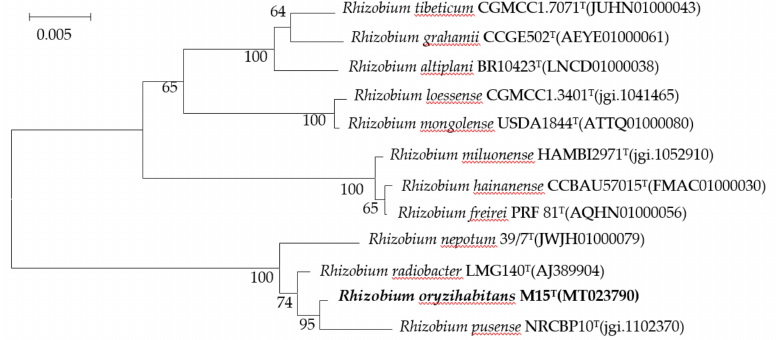
Figure 1. Phylogenetic tree generated with the neighbor-joining algorithm based on 16S rRNA gene sequences showing the phylogenetic positions of strain M15 T and related taxa. Bootstrap values with more than 50% are shown on the nodes as percentages of 1000 replicates. Rhizobium grahamii CCGE502 T (AEYE01000061) was used as an outgroup. The scale bar equals 0.005 change per nucleotide